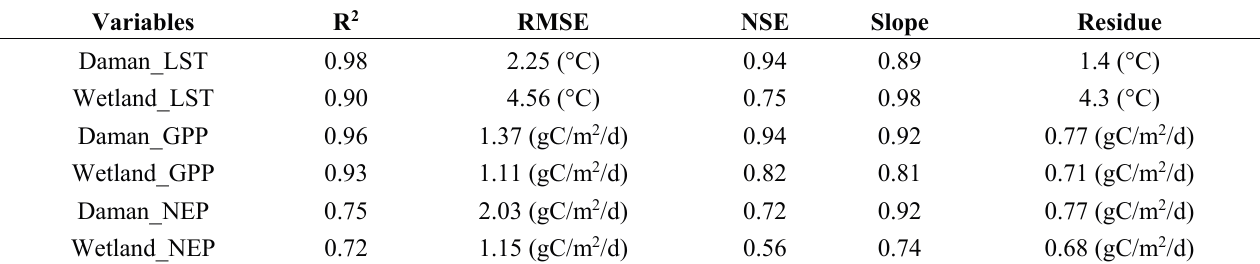
Figure 8. Validation of the RS-CFLUX model using MODIS LST as input at the Daman superstation (Daman) and Zhangye wetland station (Wetland). The slope and residual of the linear fit are shown in Table 4. Table 4. Results from the RS-CFLUX model using MODIS LST as